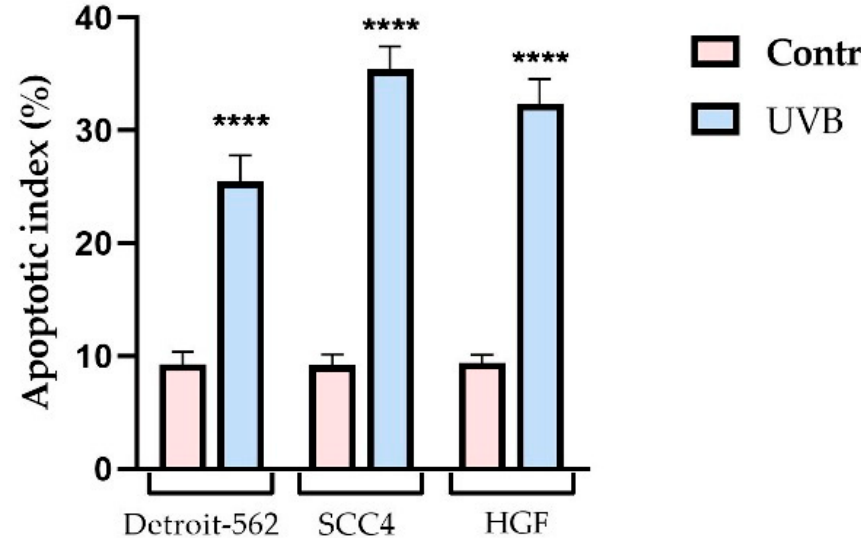
Figure 6. Analysis of the apoptotic index (AI) of Detroit-562, SCC4, and HGF, following exposure to UVB 5 J/cm 2 . Data are presented as an apoptotic index (%) normalized to control and expressed as mean values ± SD for the three independent experiments. The statistical di ff erences between the control and exposure cells were veri fi ed by applying a one-way ANOVA analysis, followed by Dun- ne tt (cid:31)s multiple comparison post hoc test (**** p < 0.0001).